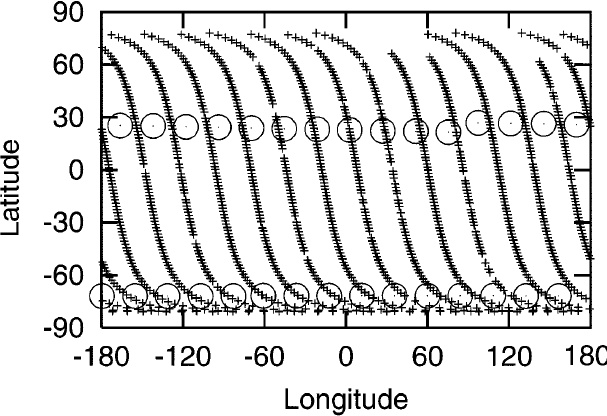
Fig. 1. Satellite tracks ( crosses ) correspond to SBUV measurements and circles correspond to SAGE II measurements on October 5, 1988